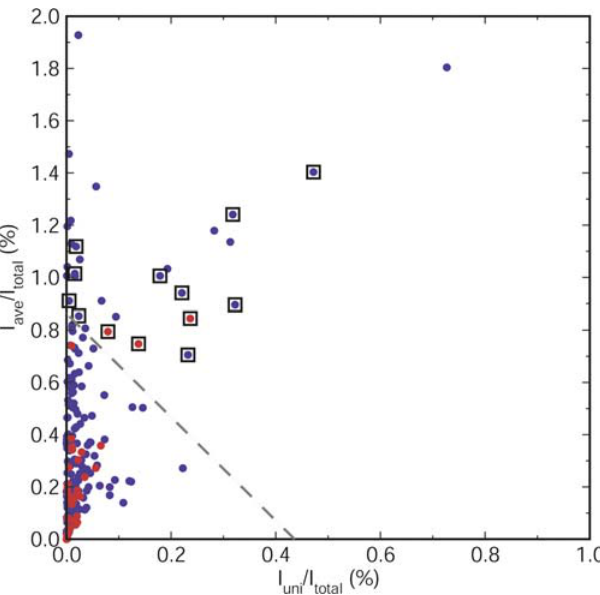
Figure 3. [I uni ,I ave ] Plot for 1TGQ Calculated Using the QUEEN Program [36] Long-range restraints (blue filled circles) and the 1TGQ sim restraints (red filled circles) are indicated. Restraints that are among the 30 most unique and most important (those above the dashed gray line) and that involve residues in either the a 2 or b 3 region (cf. Figure 1A) are indicated by black boxes. DOI: 10.1371/journal.pcbi.0020009.g003